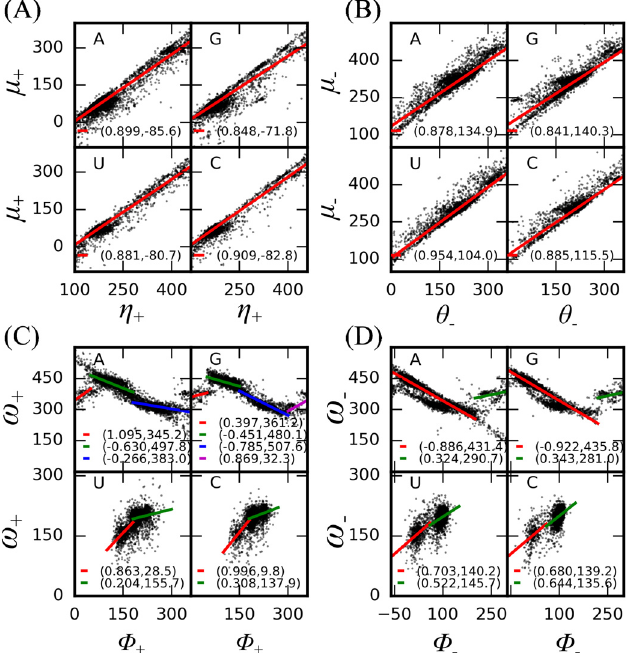
Fig 2. Linear relationship y = kx + b between (A) η + and μ + , (B) θ - and μ - , (C) ϕ + and ω + , (D) ϕ - and ω - for four types of nucleotides. The unit is degree. Different regions in (C) and (D) show different linear correlations, indicated by the thick lines. The coefficients k and b are given in the parentheses and also listed in S1 Table for clarity. Notice: in some cases the dihedral angles are deliberately extended beyond 360° to facilitate the linear fitting process. They will be mapped back to the range [0°, 360°) during their actual usage.